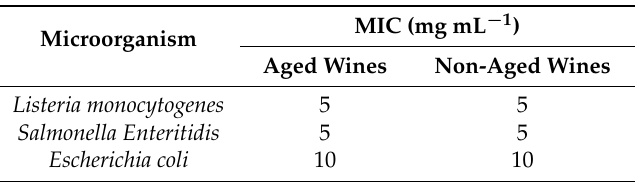
Figure 2. Typical dose-dependent inhibition profile of Commandaria melanoidins over ( A ) Listeria monocytogenes , ( B ) Salmonella Enteritis, and ( C ) Escherichia coli . Table 2. Minimum inhibitory concentration (MICs) of Commandaria wine melanoidins isolated from aged and non-aged Commandaria